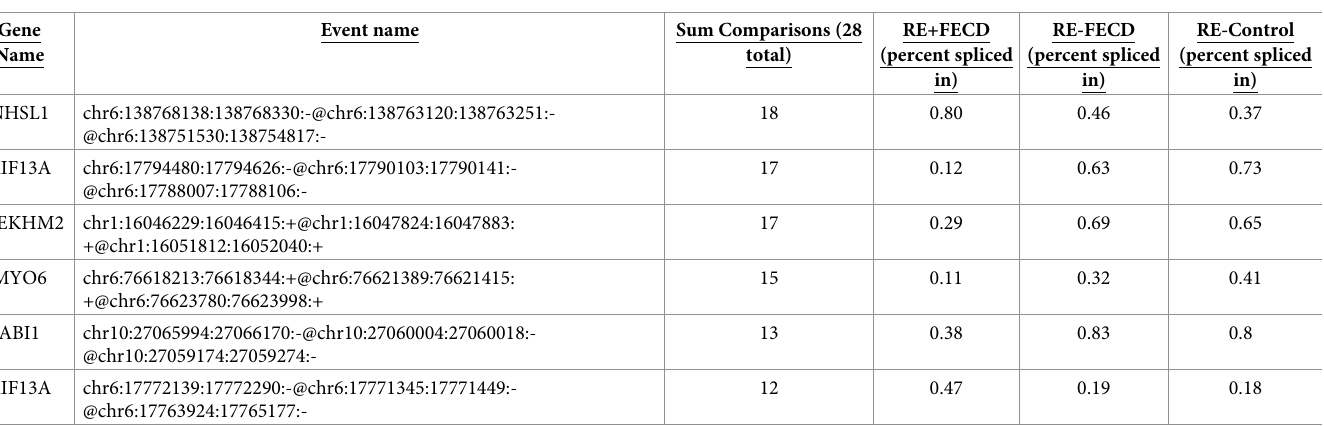
gene. In INF2, a smaller band was identified in the RE+ samples suggesting the exclusion of